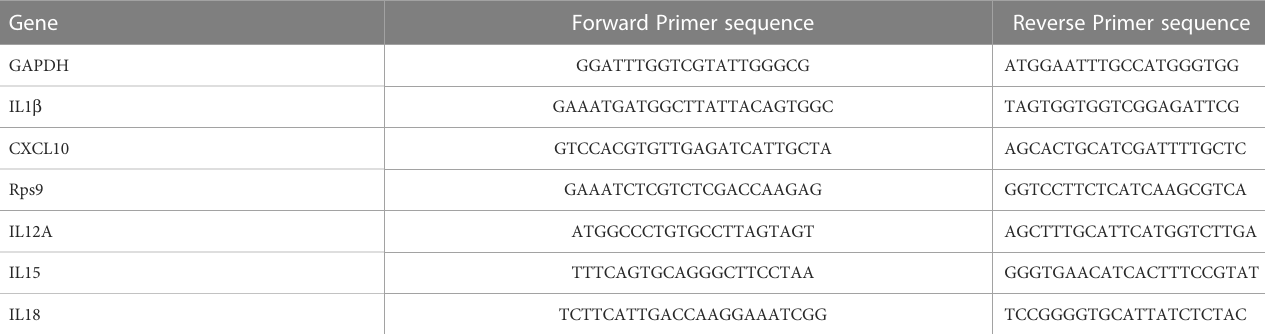
TABLE 1 Primer sequences used for RT-qPCR (synthesized by Euro fi ns Genomics). Gene Forward Primer sequence Reverse Primer sequence GAPDH